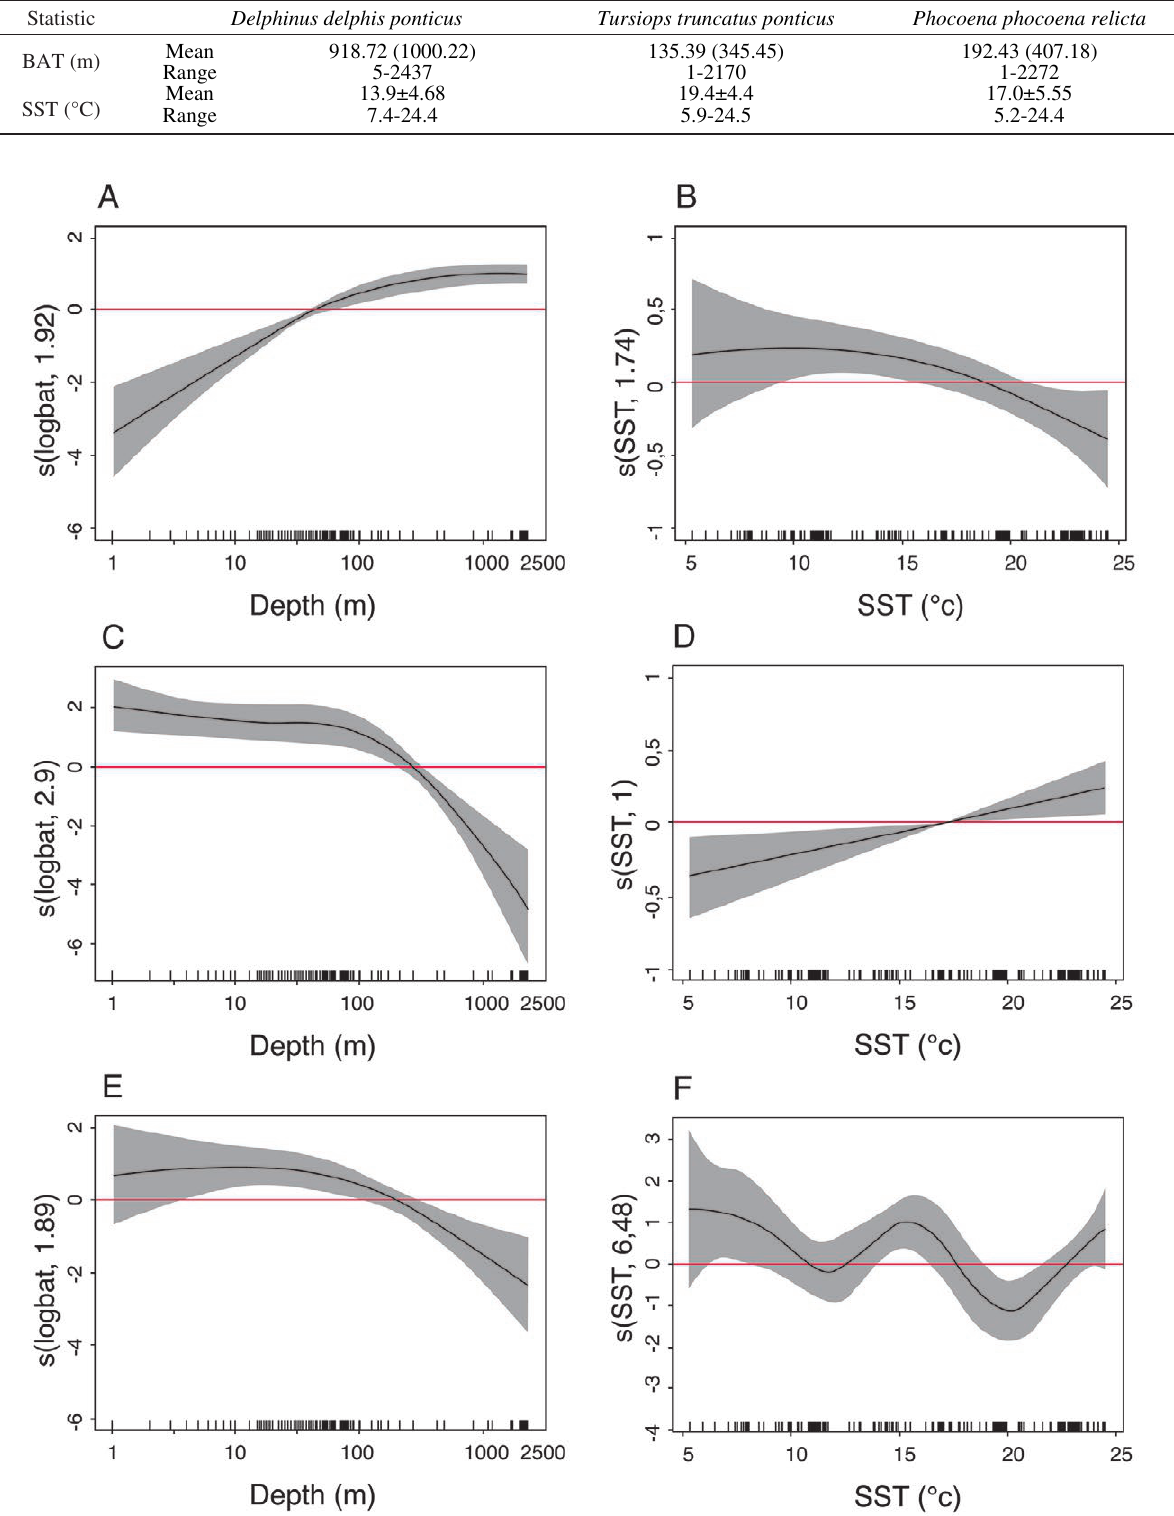
Fig. 2. – Relationships between observations of Black Sea common dolphin ( Delphinus delphis ponticus ) and (A) depth, (B) sea surface temperature (SST); between observations of Black Sea bottlenose dolphin ( Tursiops truncatus ponticus ) and (C) depth and (D) sea surface temperature (SST); and between observations of Black Sea harbour porpoise ( Phocoena phocoena relicta ) and (E) depth and (F) sea surface temperature (SST). Smooths are shown with the number of degrees of freedom in parentheses. Solid lines show the smooth estimate and grey areas the estimated 95% point-wise confidence intervals for the smoother. The zero line on the Y-axis is the mean of Y estimated by the model. The small vertical lines at the bottom of the graphs show the values at which there are